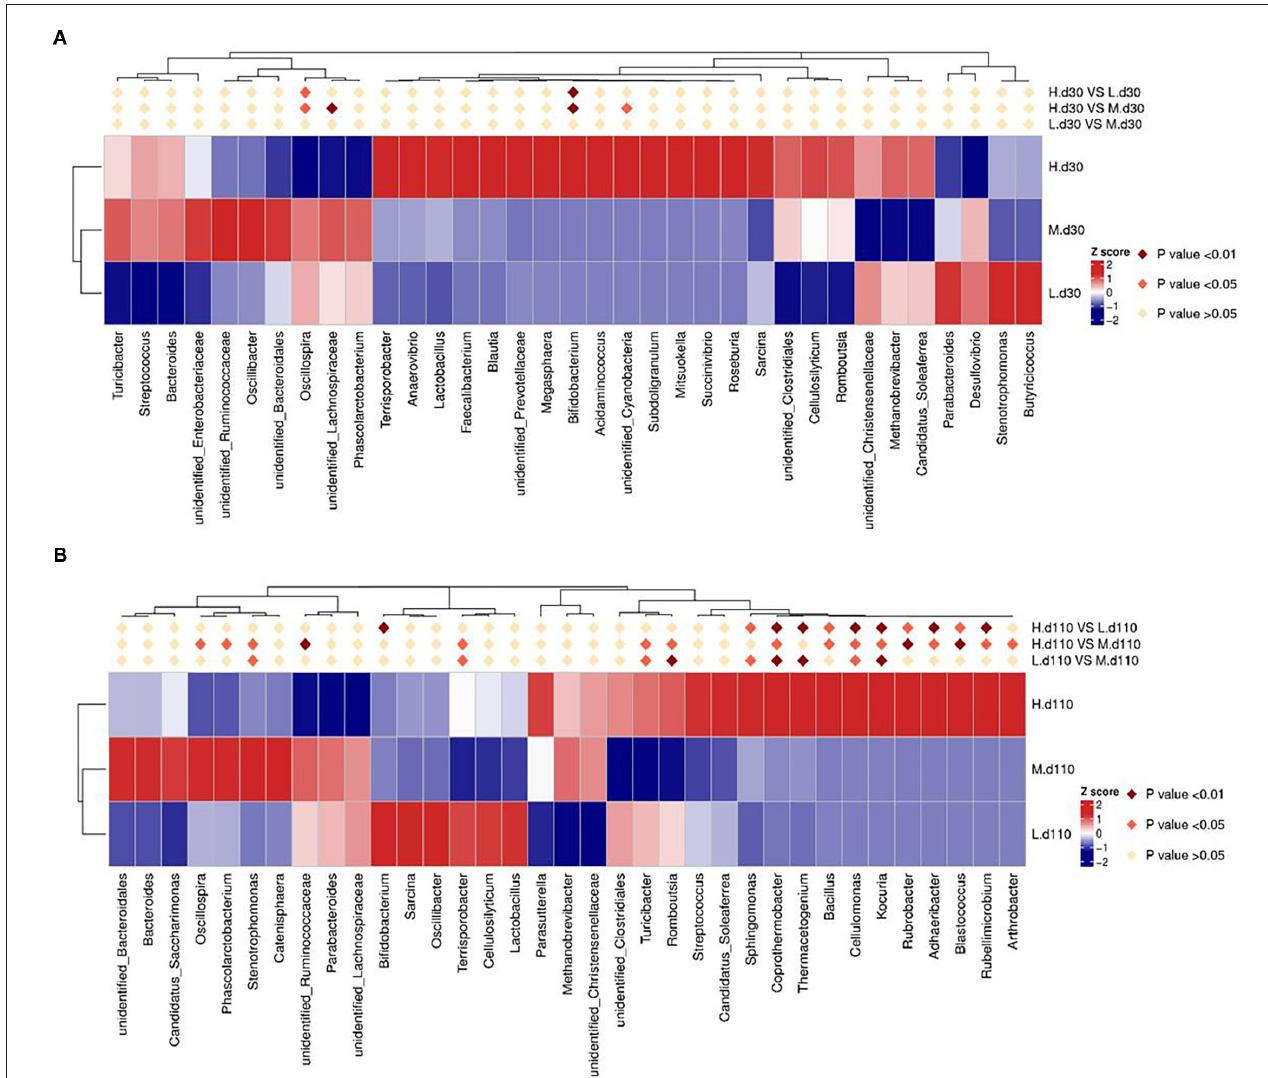
FIGURE 9 | Heat map distribution of the genera with relative abundance (top 30) in sow fecal contents for all treatments at day 30 of gestation (A) and at day 110 of gestation (B) . Different colors indicate the relative abundance of taxa. L, 1,050 mg/kg choline group; M, 1,850 mg/kg choline group; H, 2,650 mg/kg choline group. N = 8 for each